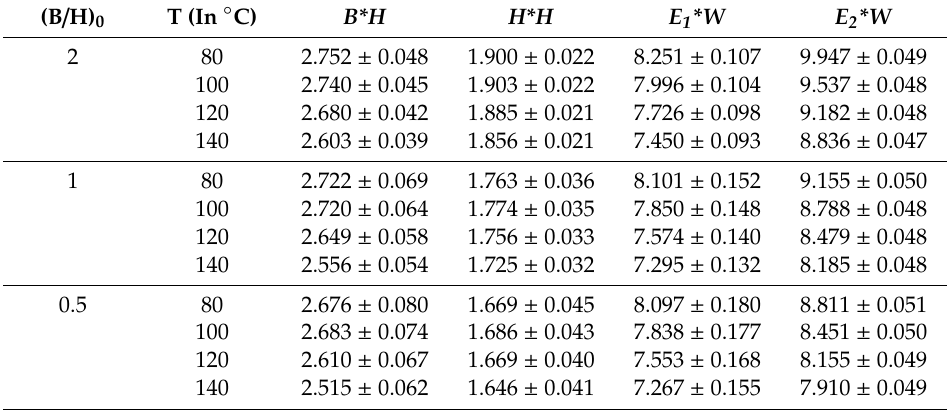
Table 1. Activity coe ffi cient products for the reactions (4) and (5) in the case of ethanol as solvent. ‘ B*H ’ indicates the product of the activity coe ffi cients for the forward reaction of benzaldehyde and heptanal; other indications are similar. ( B / H ) 0 in mol · mol − 1 .